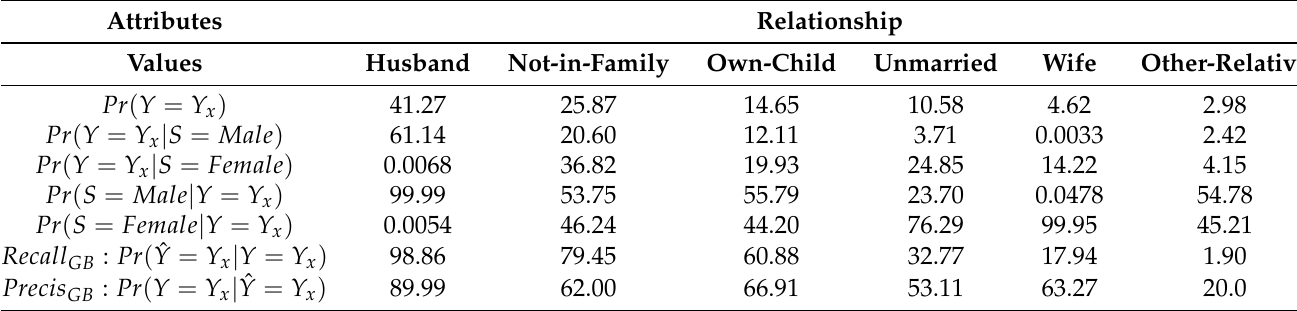
Table 6. Original distributions of the attribute relationship . Gradient Boosting (GB) Recall ( Recall GB ) and Precision ( Precis GB ) when predicting the relationship values. Note that the classifier is trained without the sensitive attribute. Numerical values are given in